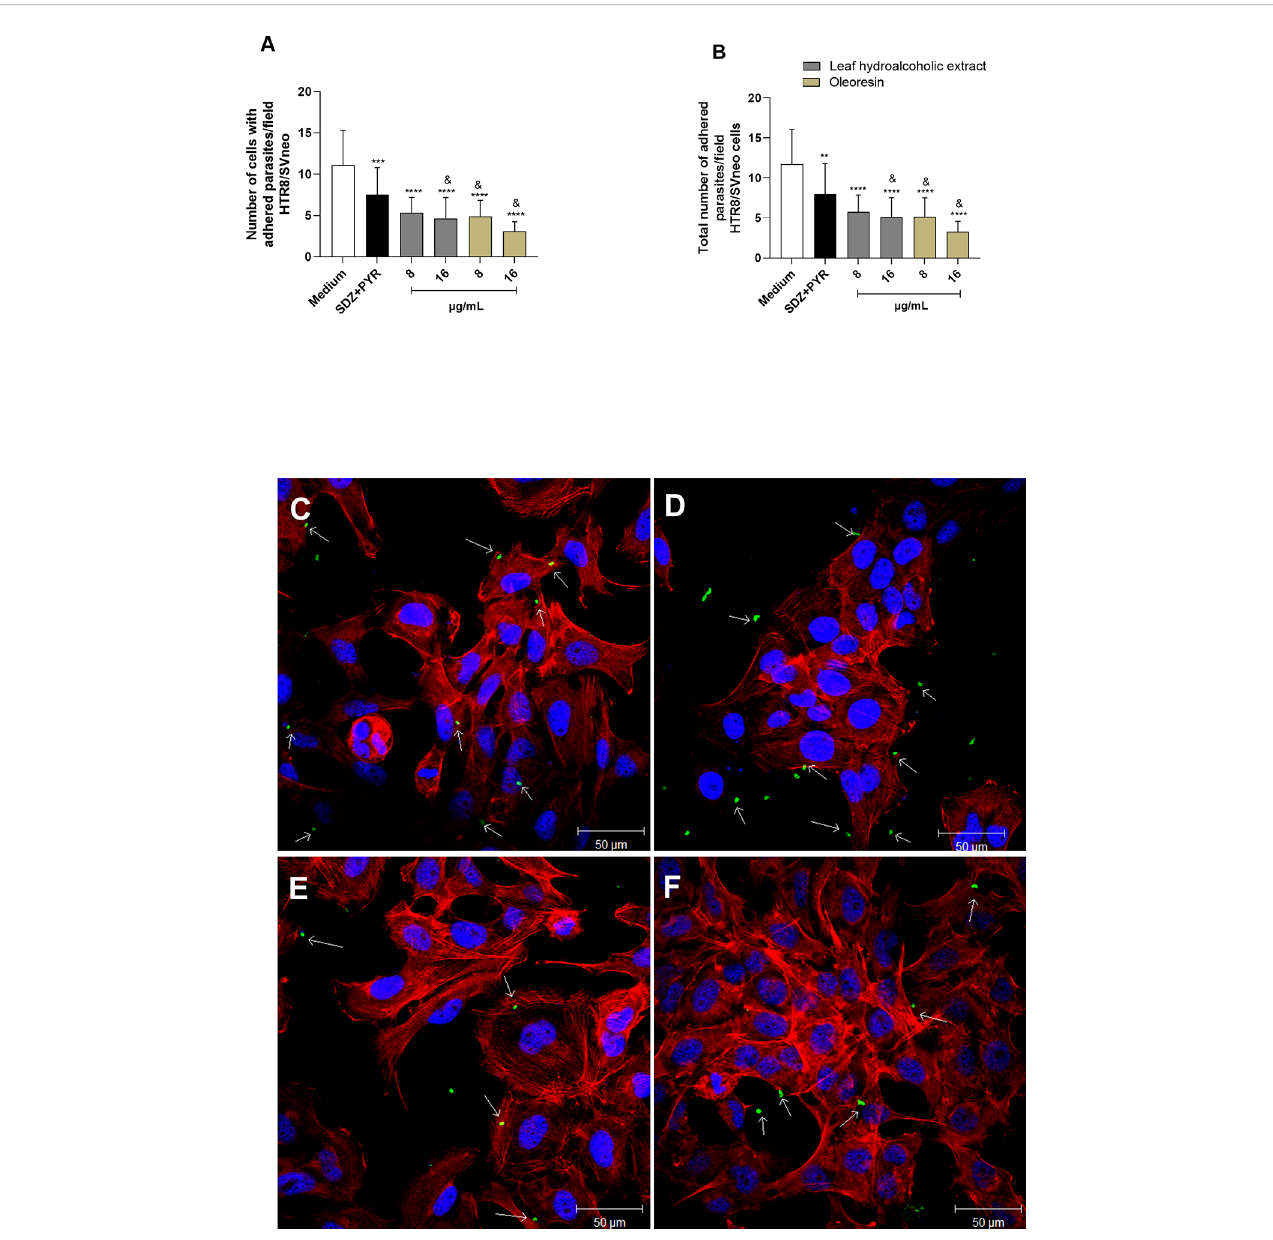
FIGURE 5 Adhesion assay in HTR8/SVneo cells. T. gondii tachyzoites were preincubated for 1 h with the hydroalcoholic extract or oleoresin from C . multijuga , and then allowed to interact with previously fi xed HTR8/SVneo cells during 3 h. As control, tachyzoites were incubated with SDZ + PYR or only medium (medium). The number of cells with adhered parasites (A) and the total number of adhered parasites (B) were determined in a total of 20 fi elds examined randomly with 20X objective lens. Representative images highlighting the effect of the treatments on the tachyzoite-host cell interaction: (C) untreated parasites, (D) 16 µg/mL hydroalcoholic extract, (E) 8 µg/mL oleoresin, and (F) 16 µg/mL oleoresin. The results were expressed as means ± standard deviation of two experiment performed in three replicates. Signi fi cant differences detected by One-Way ANOVA and Bonferroni ’ s multiple comparisons post-test. ** P < 0.001, *** P < 0.0001 or **** P < 0.00001 in relation to the medium. & P < 0.05 in relation to SDZ + PYR. White arrows indicate tachyzoites attached to HTR8/SVneo cells. The cell nucleus is labeled with TOPRO-3 (blue). T. gondii tachyzoites labeled with Alexa Fluor 488- conjugated anti-mouse IgG (green). Phalloidin-TRITC labeled F-actin is shown in red. Scale bar: 50